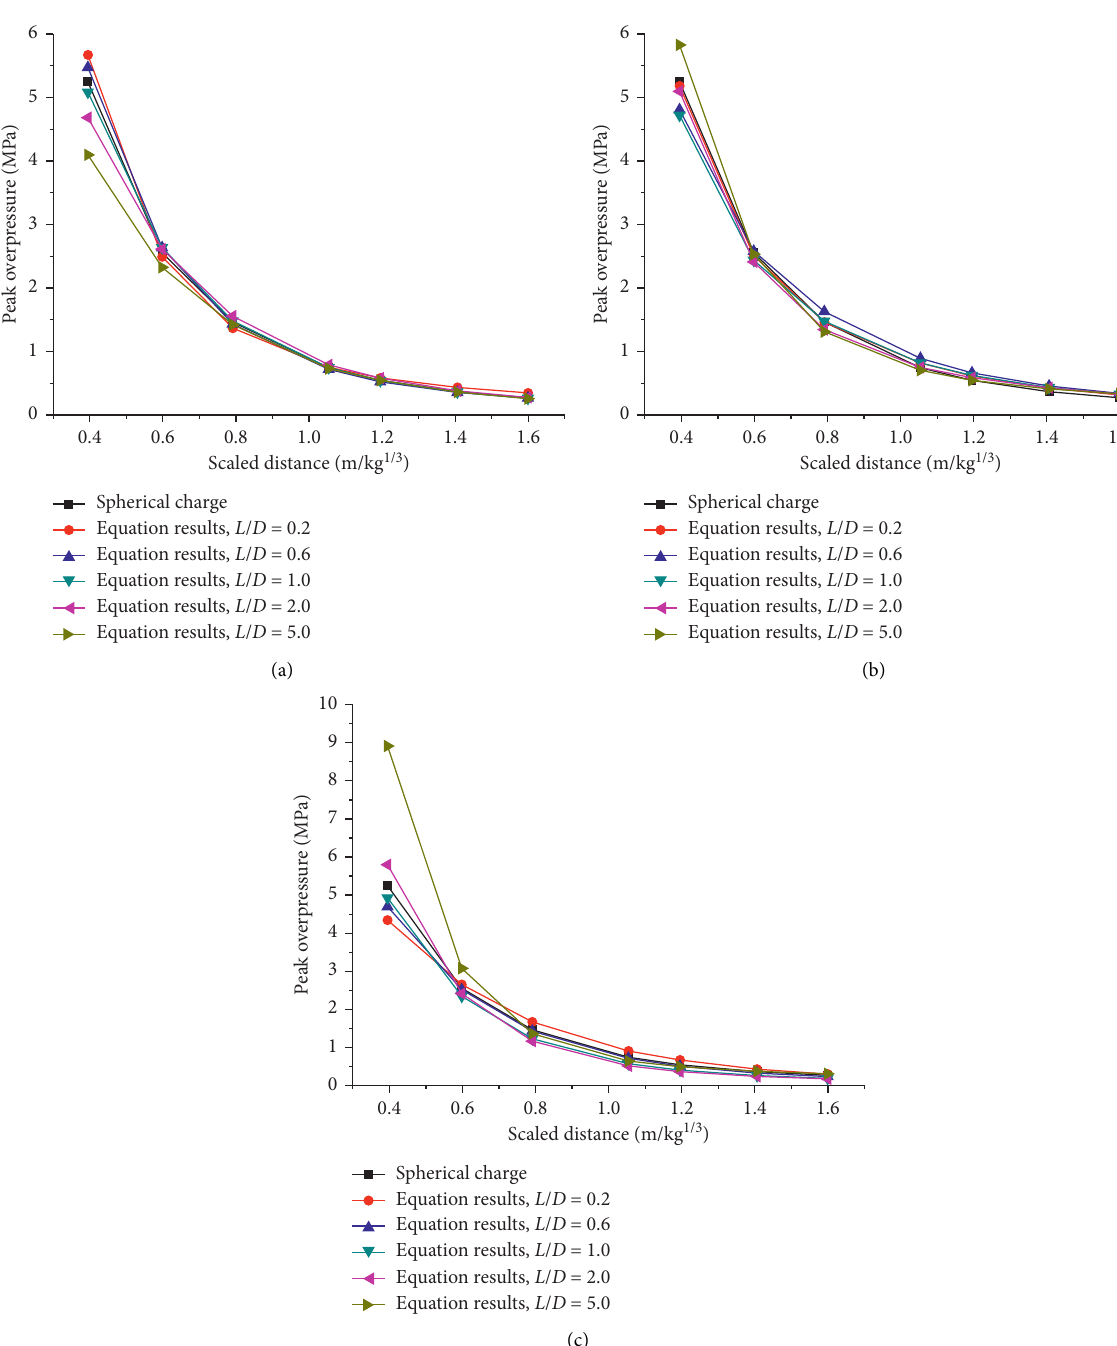
Figure 9: Comparison of peak overpressure between the spherical explosive and empirical results of the cylindrical explosives. (a) Radial direction. (b) 45 ° direction. (c) Axial